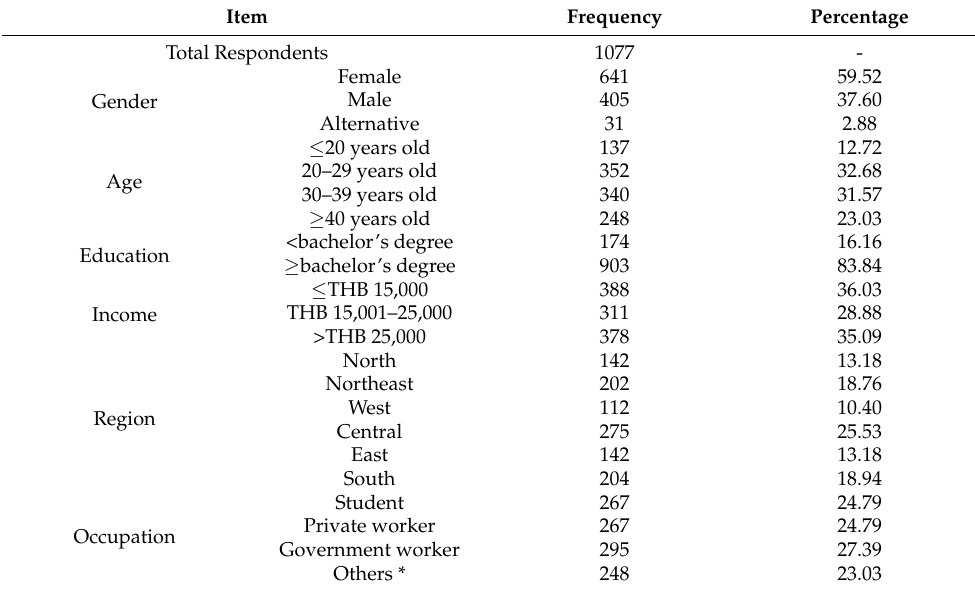
Table 1. Socio-economic characteristics of surveyed